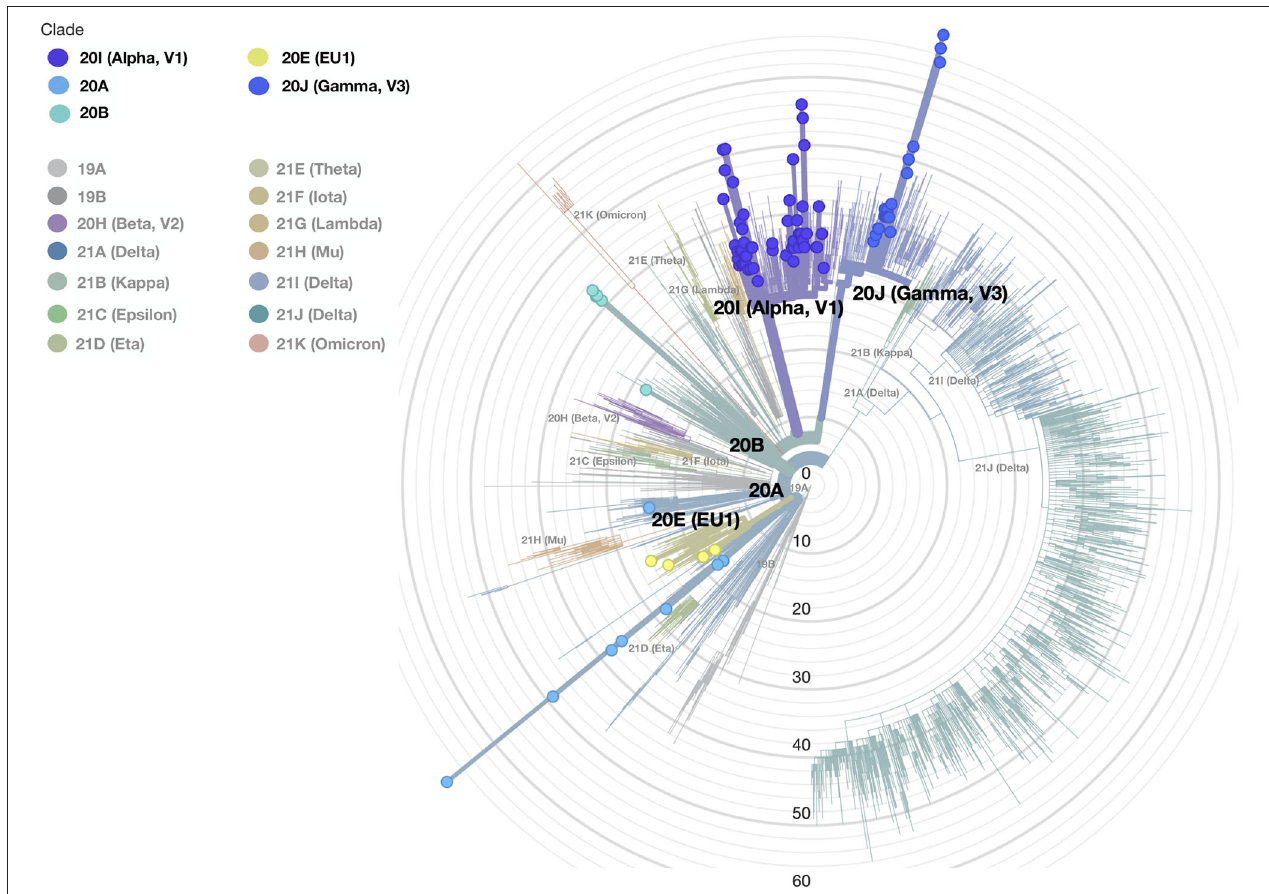
FIGURE 2 | The phylogenetic tree of all SARS-CoV-2 samples was made with the Nextclade and globally represents position and clade clustering (Nextrain nomenclature). Our different clades are defined by colors (legend of colors is on the top left); the small circles show our samples, and the gray concentric circles represent the scale of the tree defined as the difference in mutation profiles between each sample and the reference